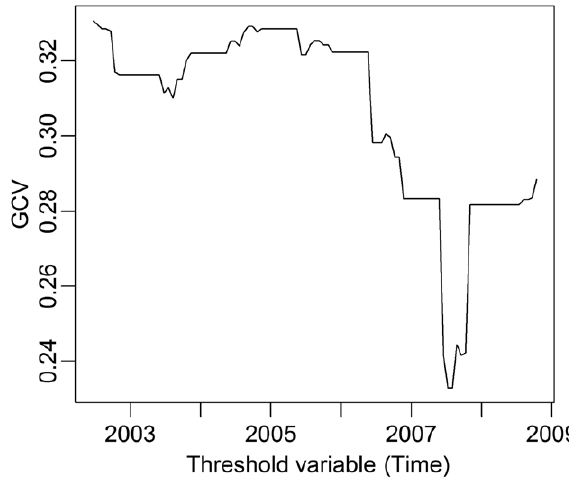
Fig. 5 . – GCV profile for the threshold estimation for the variable time in the Northern